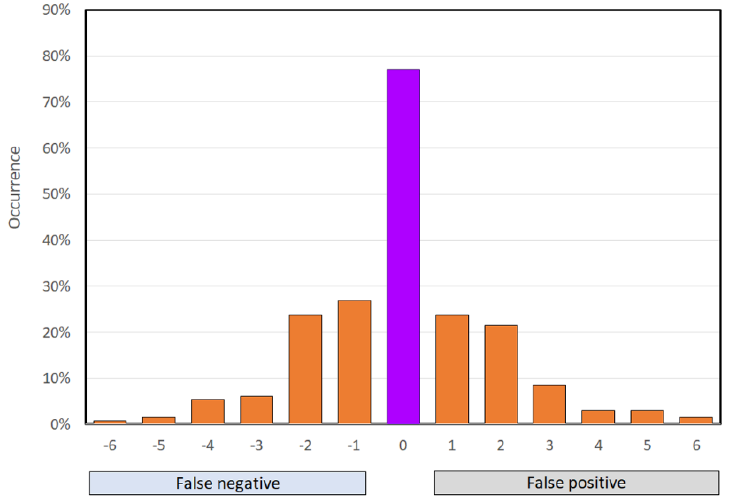
Figure 9. Number of mineral phase matches (purple), false negatives and false positives using score matching of first order maxima of FTIR spectra to predict mineral phase occurrences in a test spectrum.